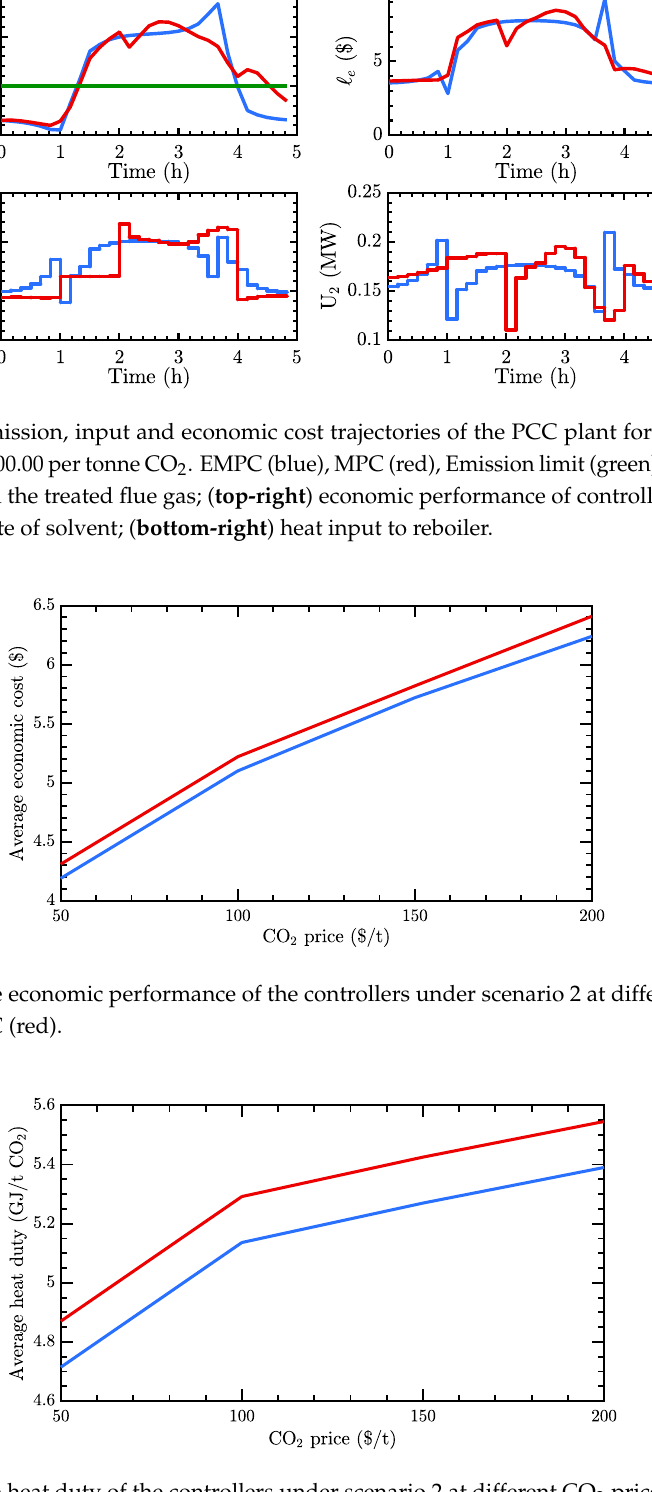
Figure 14. Average heat duty of the controllers under scenario 2 at different CO 2 prices. EMPC (blue), MPC